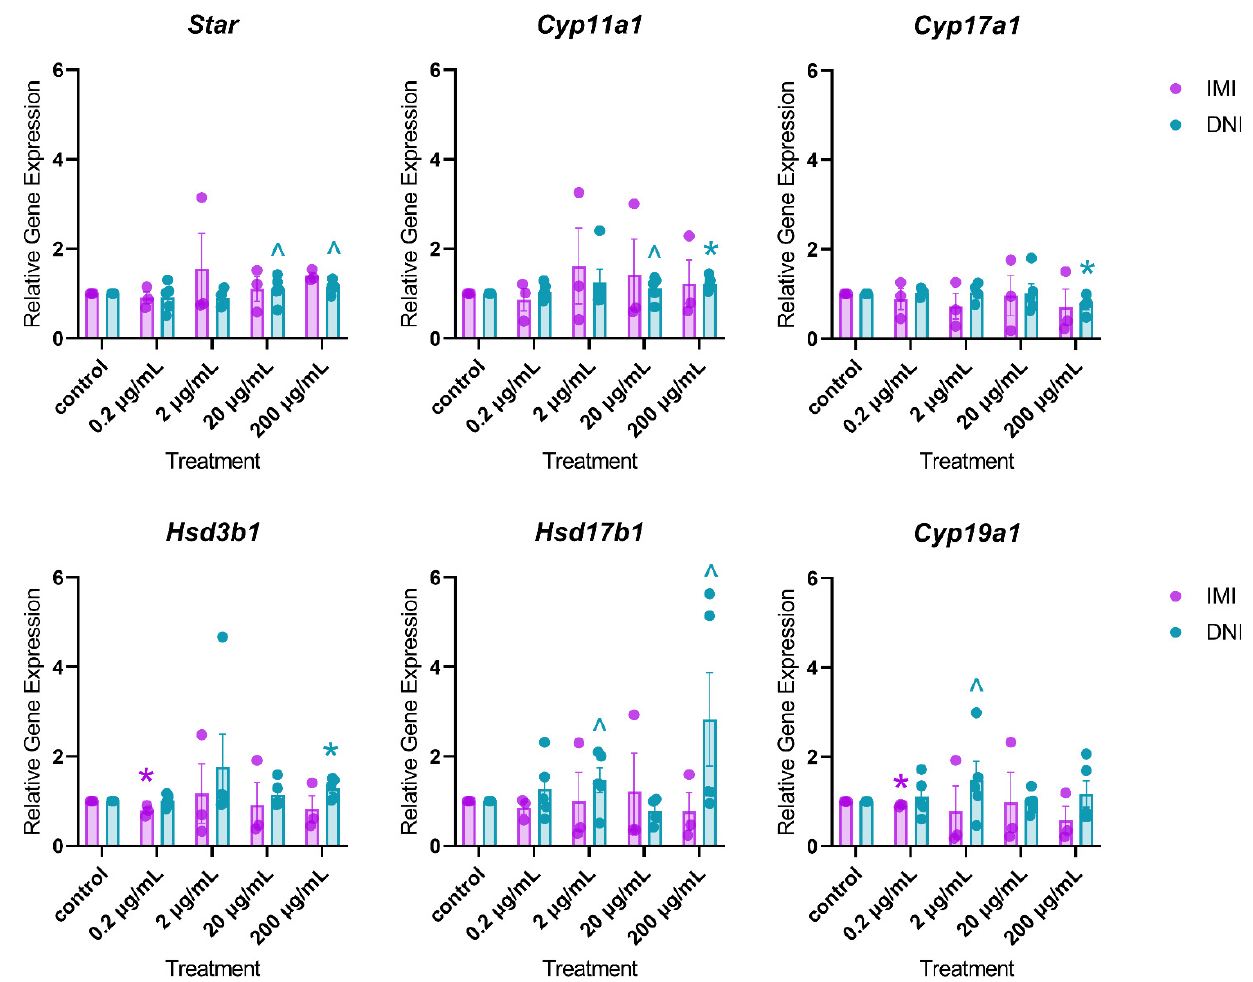
Figure 8. Effects of IMI and DNI on the gene expression of steroidogenic regulators in antral follicles treated with a vehicle (DMSO or water), IMI, or DNI (0.2–200 µ g/mL) for 96 h. After the culture period, RNA was extracted from snap-frozen follicles, reverse-transcribed to cDNA, and subjected to qPCR. The graphs indicate means ± SEMs from 3–5 separate cultures (8–12 follicles per treatment per culture). * p < 0.05; ^ 0.05 < p < 0.10.